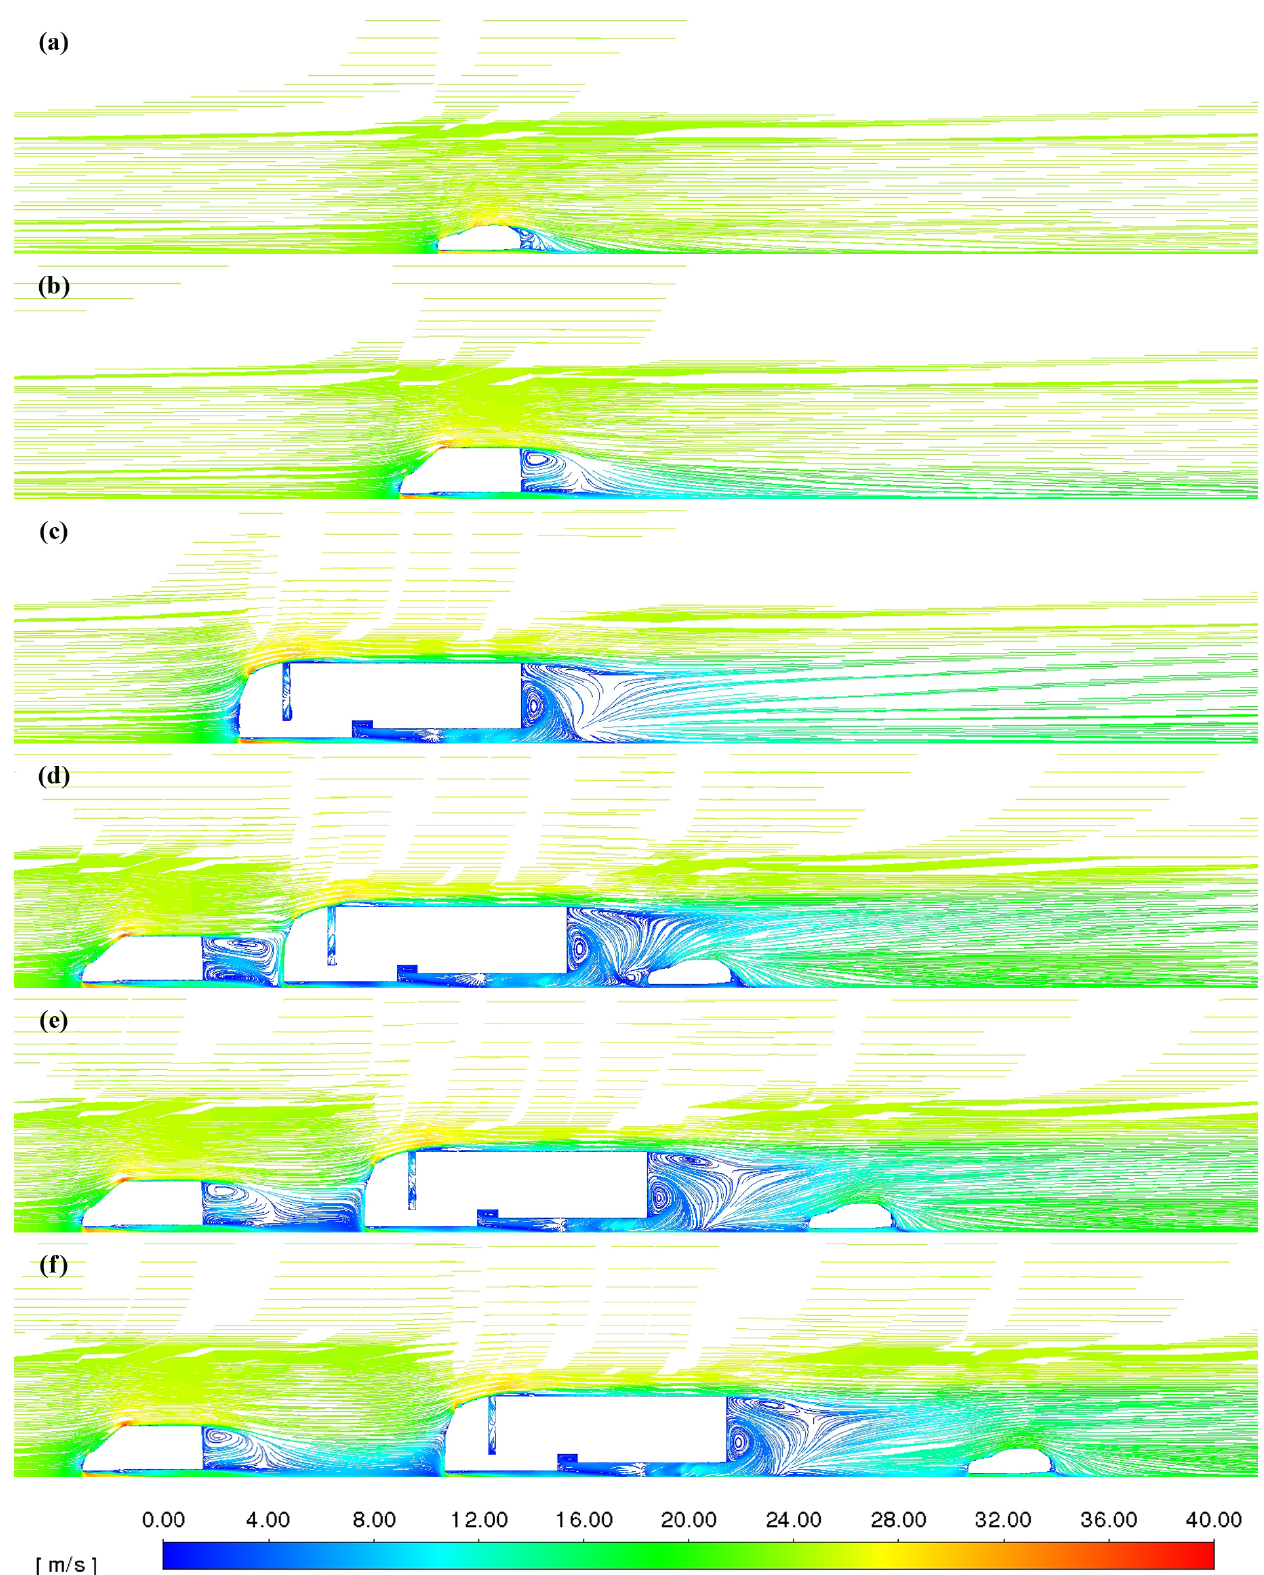
Figure 12. A fragment of streamlines around the vehicles. View at the symmetry plane. ( a ) Single car, ( b ) single van, ( c ) single truck, ( d ) column of vehicles with a spacing of 4 m, ( e ) column of vehicles with a spacing of 8 m, ( f ) column of vehicles with a spacing of 12